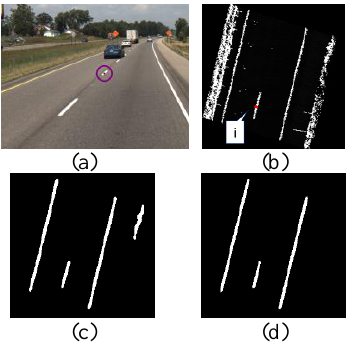
Figure 12. False positive problem: (a) RGB imagery of location i (b) original intensity images, and images with predicted lane markings from (c) U-net model 1 and (d) U-net model 2 in